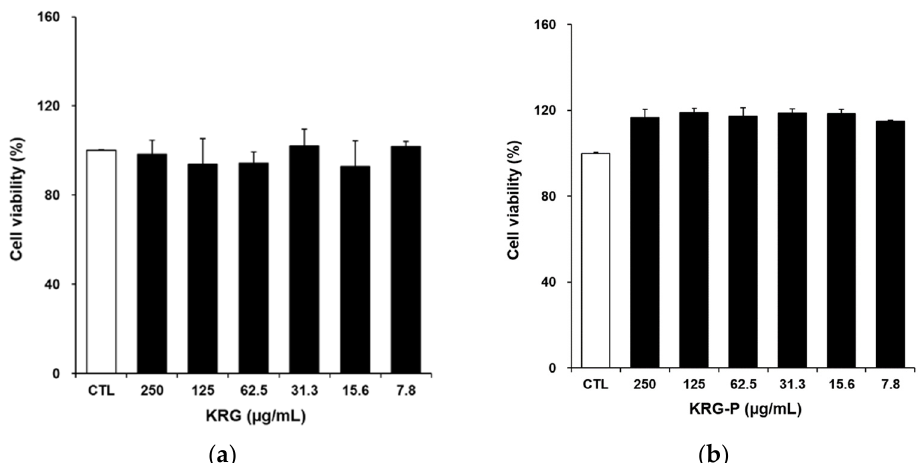
Figure 1. Cytotoxic effect of KRG ( a ) and KRG-P ( b ) isolated from Korean red ginseng on RAW264.7 macrophage cells in vitro. RAW264.7 macrophage cells (1.0 × 10 5 cells/well) were treated with KRG or KRG-P using a series of concentrations (7.8~250 µg/mL) in 96-well flat-bottomed microplates for 24 h. Cytotoxicity was determined using the EZ-Cytox based colorimetric assay. CTL; control. Data are presented as the means ± SD of three independent experiments.